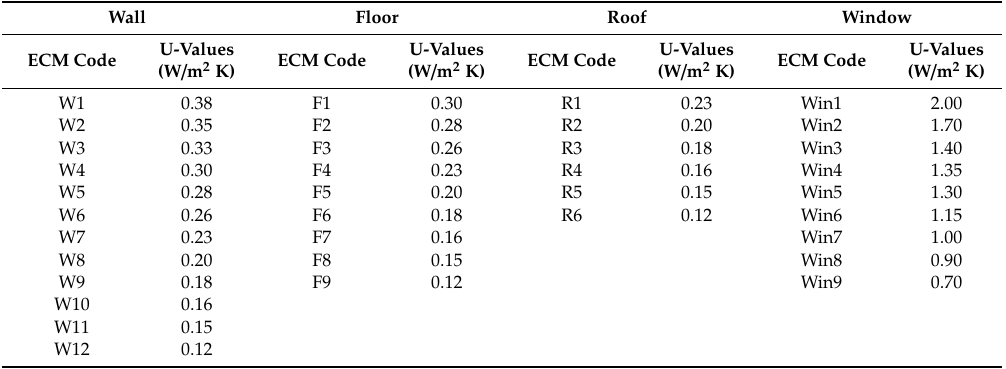
Table 8. Values of performance parameters for architecture